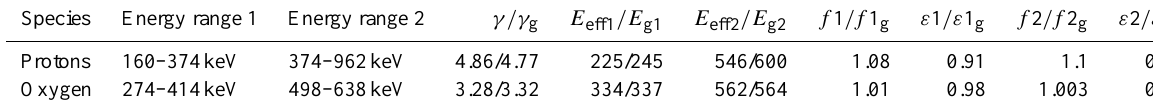
Table 1. Energy spectral index γ , effective energy, deviations of phase space density and energy density.